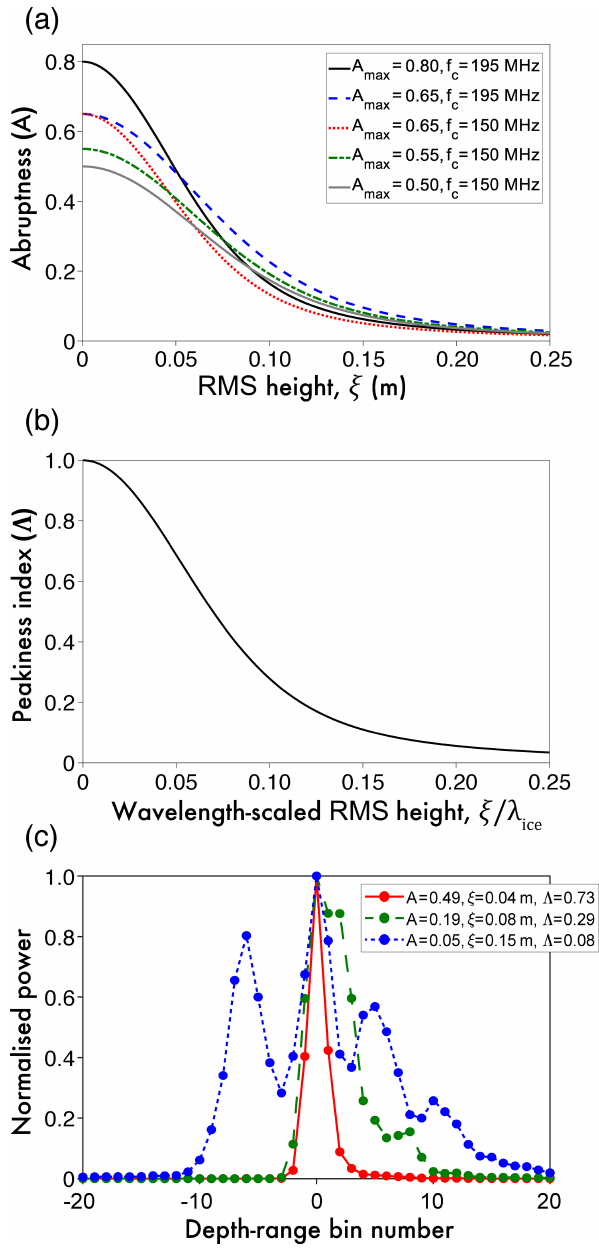
Figure 4. Estimation of scattering-derived roughness and data com- bination for bed-echo peakiness. (a) Abruptness as a function of RMS height for different CReSIS field seasons: solid black curve – 2010 DC8; long dashed blue curve – 2011 TO, 2011 P3, 2012 P3, 2013 P3, and 2014 P3; dotted red curve – 2006 TO; dashed green curve – 2005 TO; and solid grey curve – 2008 TO and 2009 TO. (b) Peakiness index as a function of wavelength-scaled RMS height. (c) Example bed-echo waveforms, their abruptness ( A ), peakiness index ( (cid:51) ), and scattering-derived roughness ( ξ ). The plots are for the 2011 P3 field season, which has maximum A ∼ 0 .